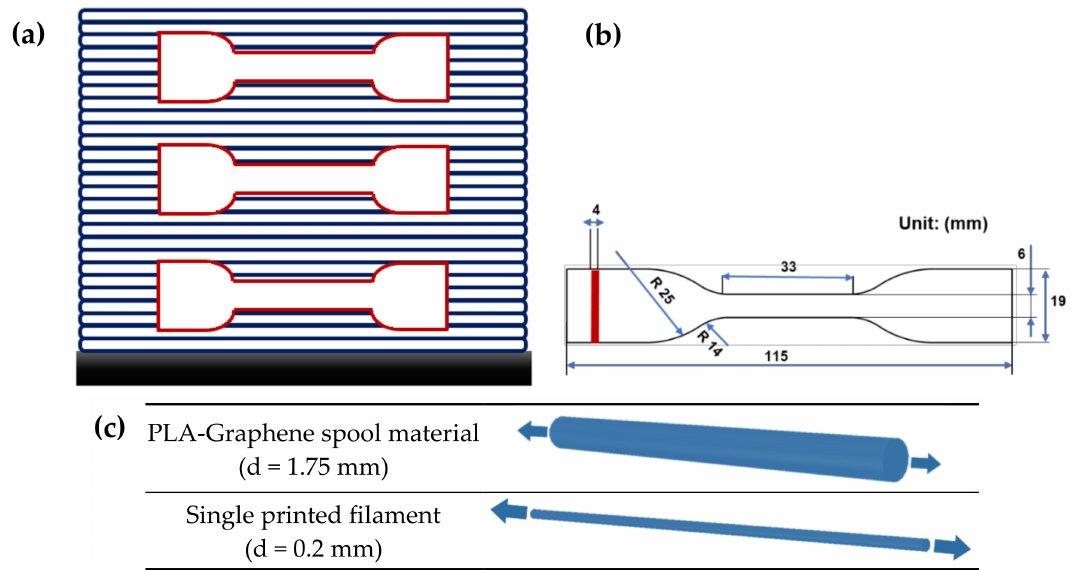
Figure 1. Representation of ( a ) location of samples on the printed solid blocks, ( b ) printed samples based on ASTM D638 type IV, and ( c ) proposed printed filaments to perform tensile